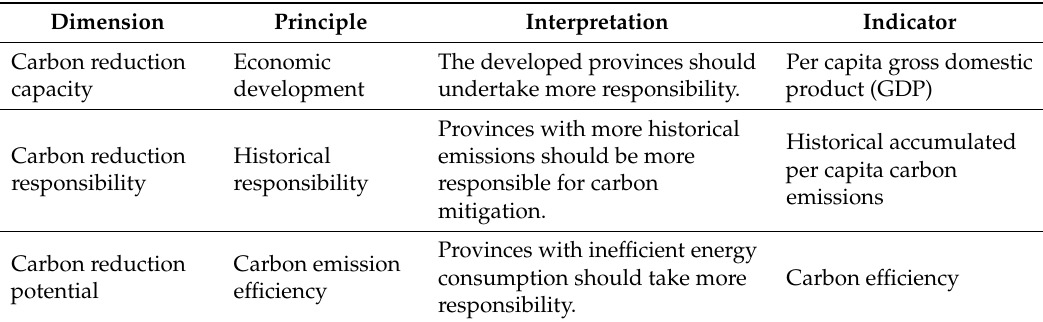
Table 1. Principles of carbon emission